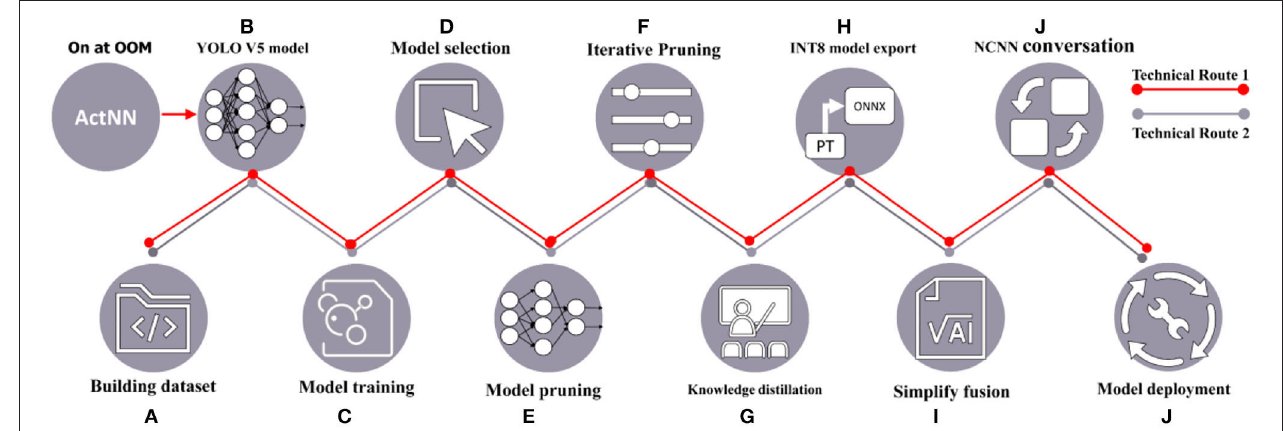
FIGURE 1 | Technical route